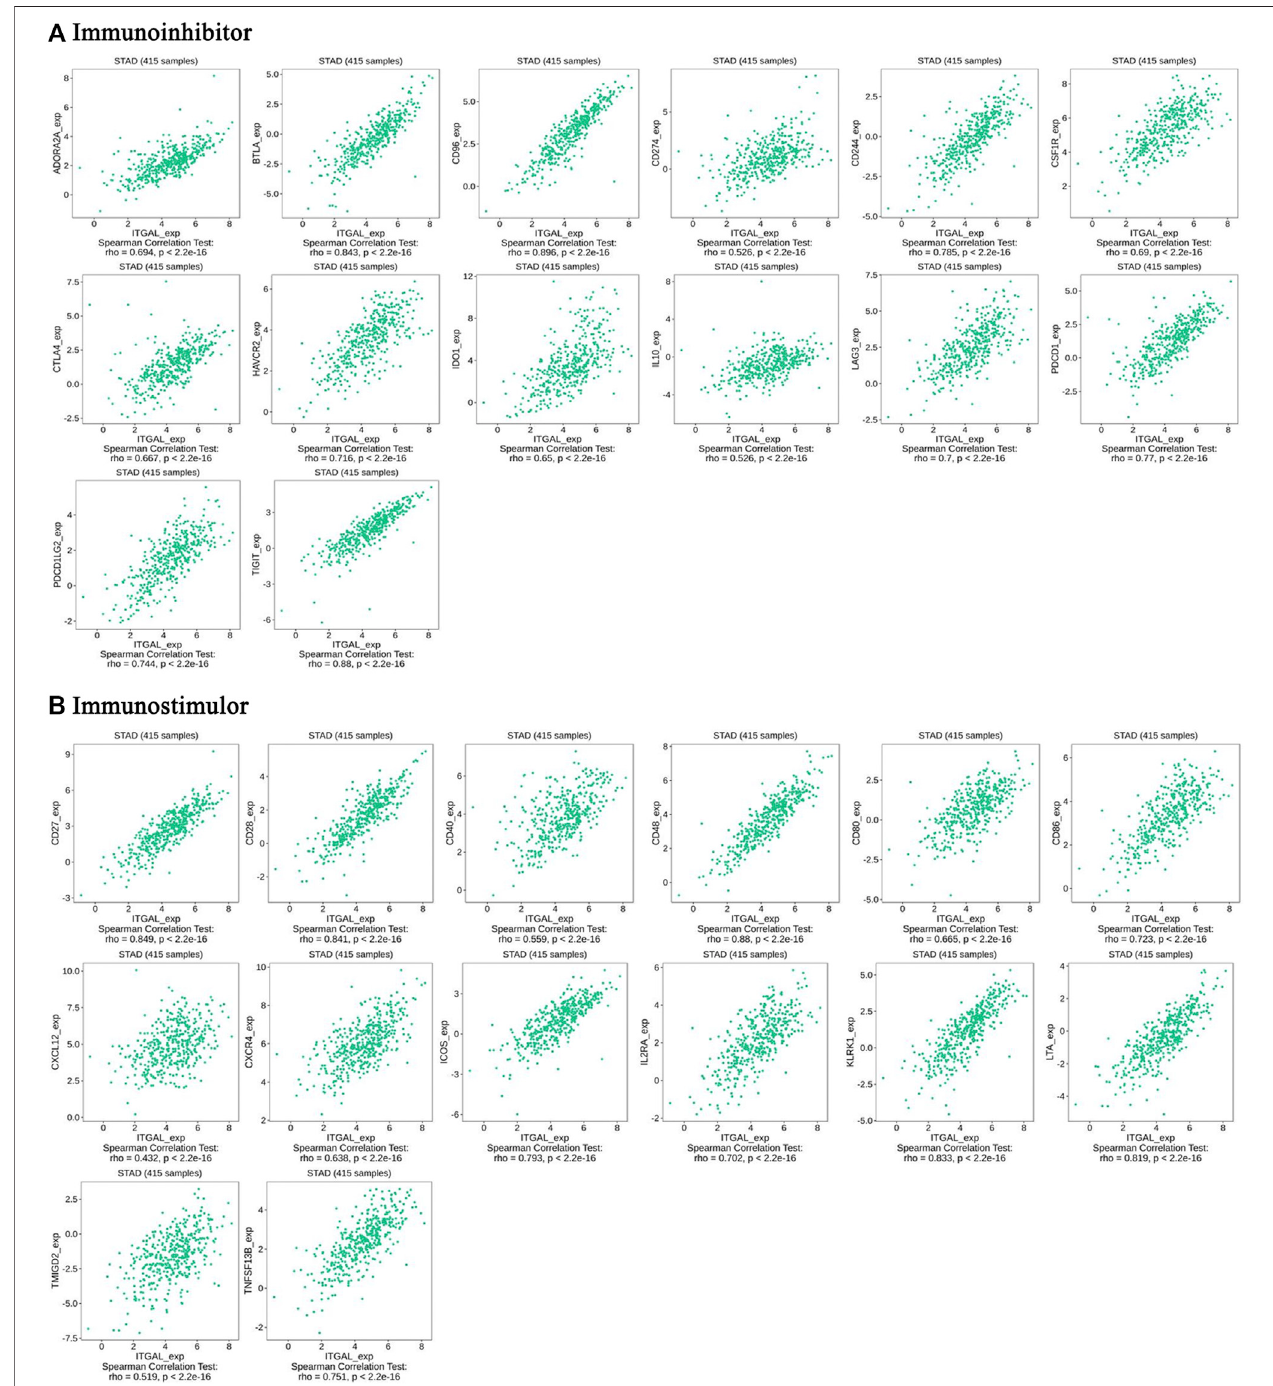
FIGURE 6 | The expression of ITGAL is associated with immunomodulators in gastric cancer. (A) Correlation between ITGAL expression and immunoinhibitors in gastric cancer available at TISIDB database. (B) Correlation between ITGAL expression and immunostimulators in gastric cancer available at TISIDB database. Color images are available